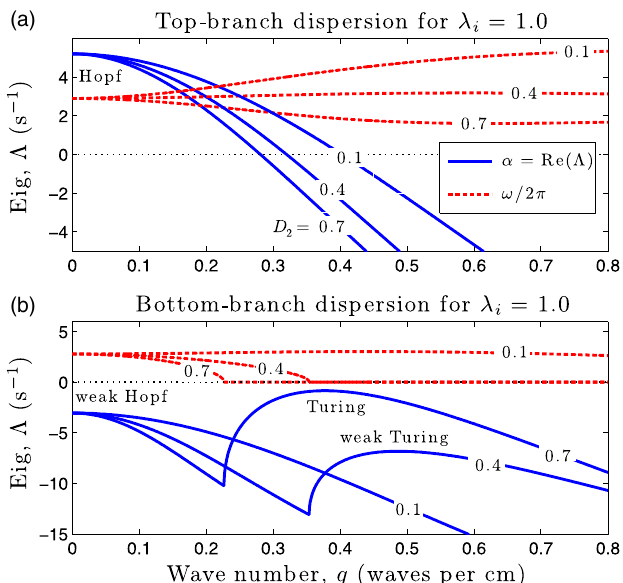
FIG. 4. Predicted dispersion curves for spatially homogeneous cortex for (a) top branch and (b) bottom-branch equilibria at 1 : 0 (see Fig. 3). Blue traces show the real part of the (cid:13) i ¼ dominant eigenvalue, (cid:4) ¼ Re ð (cid:3) Þ , as a function of wave number q ; dashed-red traces indicate oscillation frequency (in Hz) f ¼ != 2 (cid:11) ¼ Im ð (cid:3) Þ = 2 (cid:11) . Selected inhibitory diffusion values are D 2 = cm 2 ¼ 0 : 7 , 0.4,